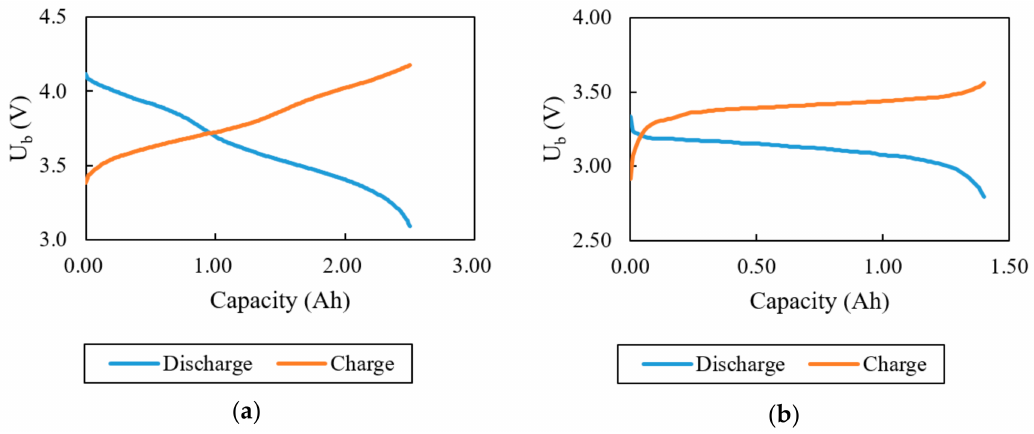
Figure 8. Battery discharge and charge curve for ( a ) NCA and ( b ) LFP